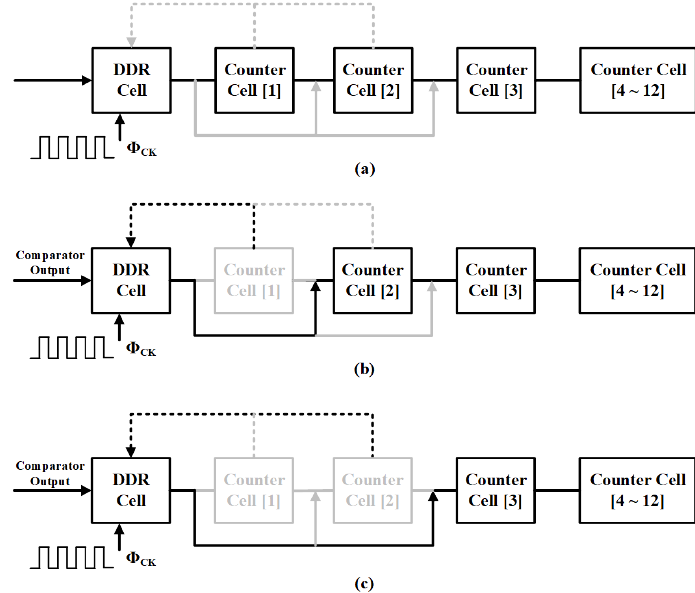
Figure 13. Counting process of the DDR counter in ( a ) HG; ( b ) MG; ( c ) LG scheme.